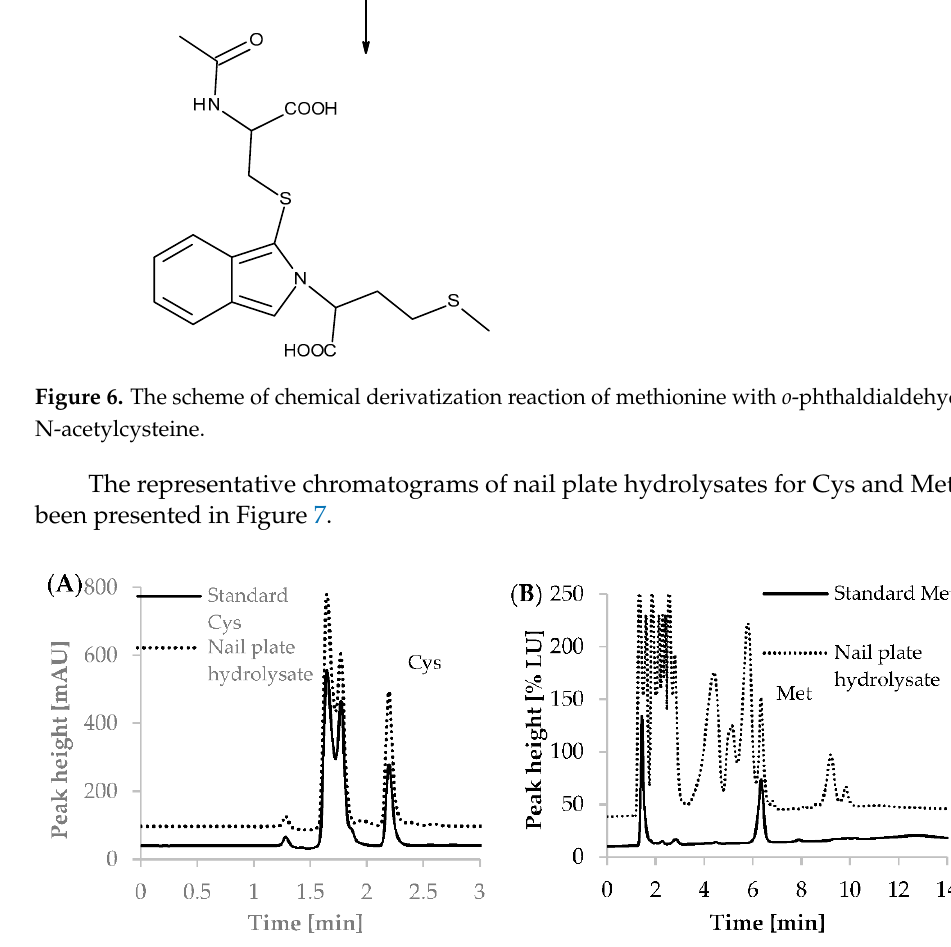
Figure 7. Representative chromatograms for Cys in human nail plate hydrolysates after reduction with TCEP and derivatization with CMQT ( A ) and for Met in human nail plate hydrolysates after on-column derivatization with OPA and NAC ( B ). Chromatographic conditions as described in Sections 3.2.4 and 3.2.5.